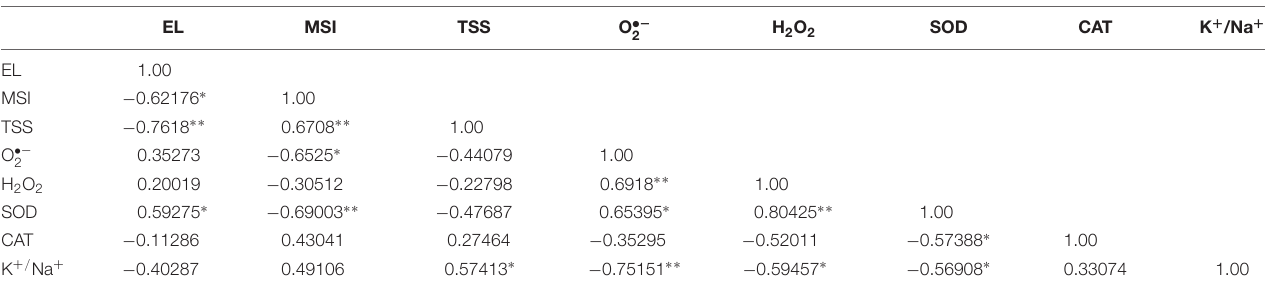
TABLE 5 | Correlation coefficient(r) between biochemical parameters of transgenic and WT plants exposed to combinatorial (NaCl + SA) stress. EL